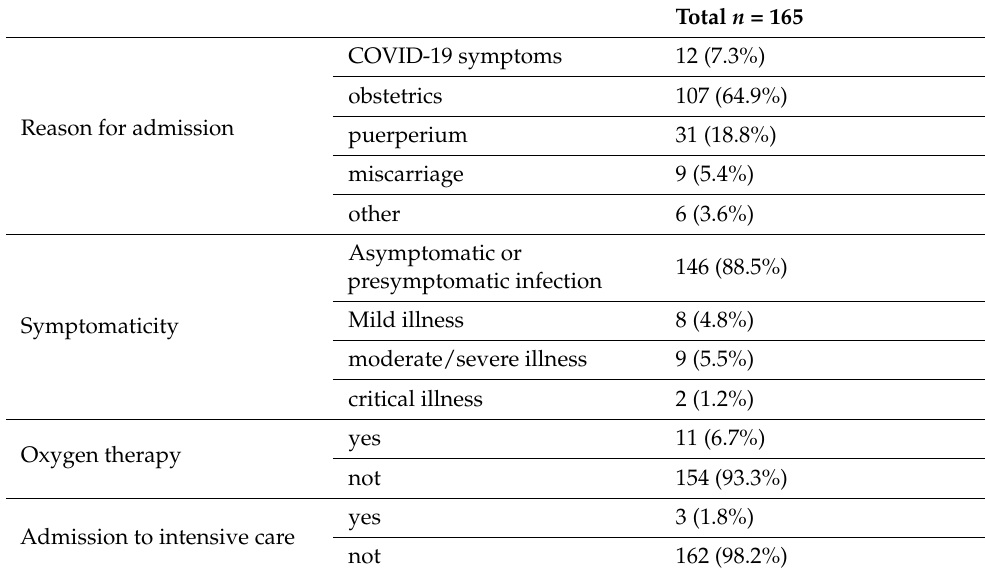
Table 1. Descriptive